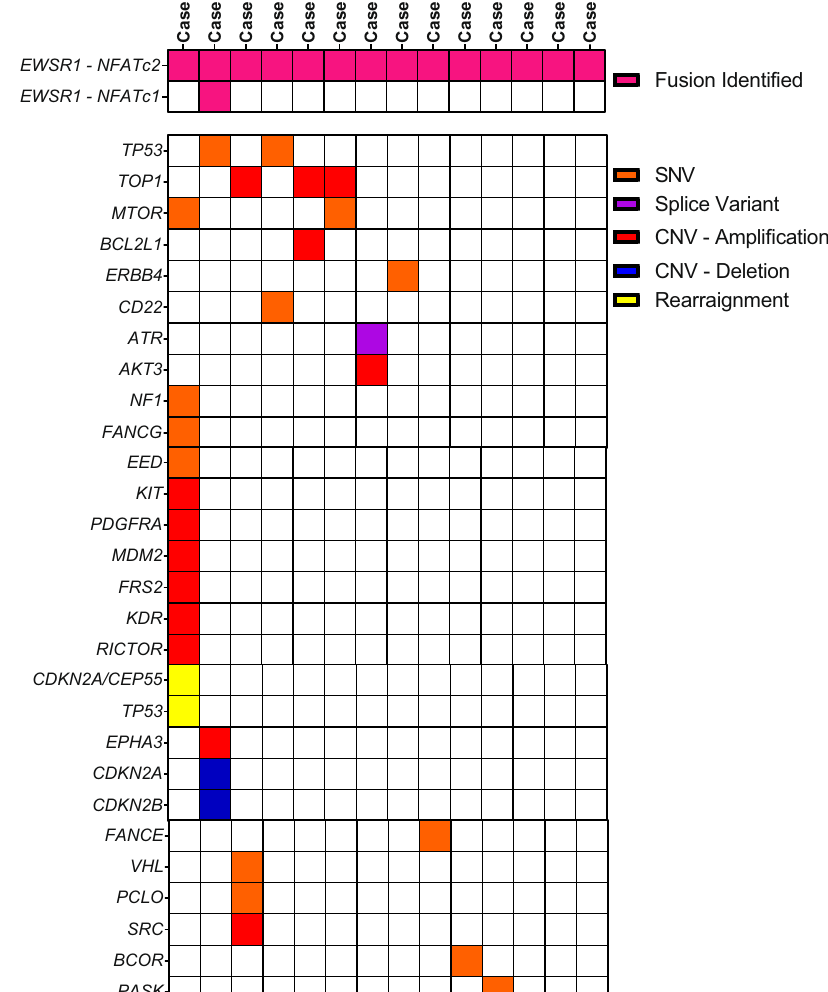
bottom quartile of NFATc2 expression (Supplementary Table 5). NFATc2 -High tumors were statistically associated with poor overall